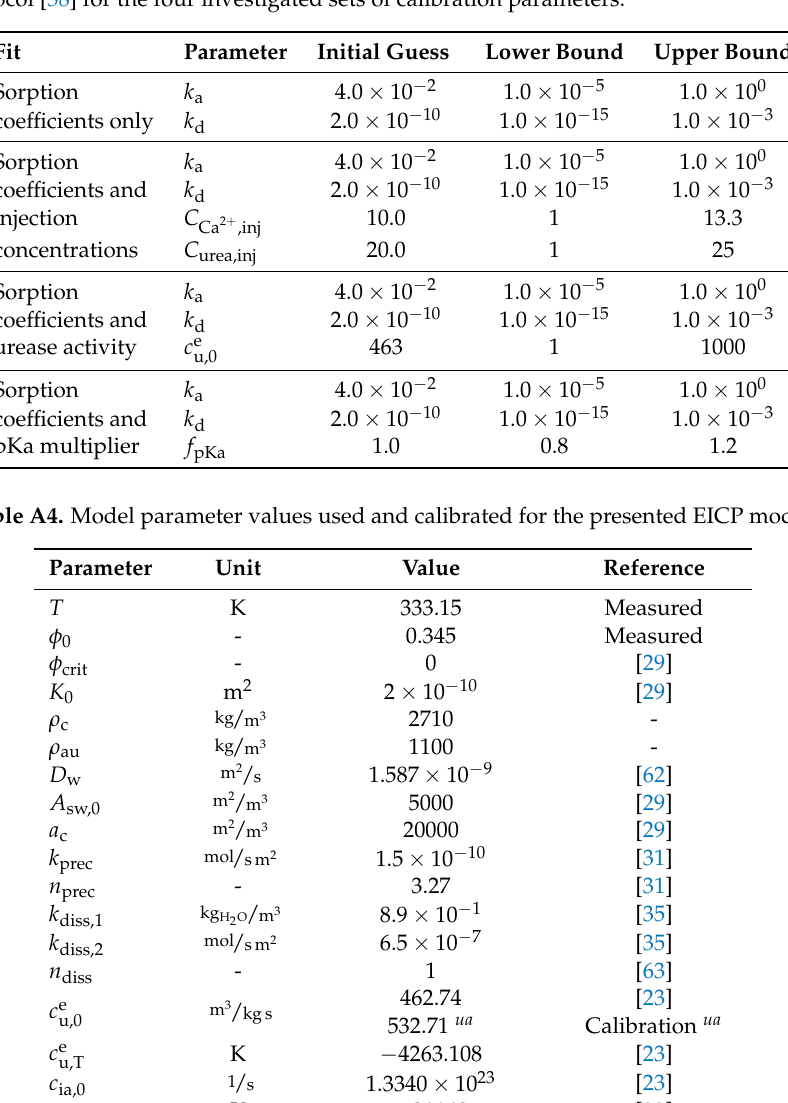
Table A3. Initial parameter values and upper and lower parameter bounds set for calibration with the PEST protocol [58] for the four investigated sets of calibration parameters.